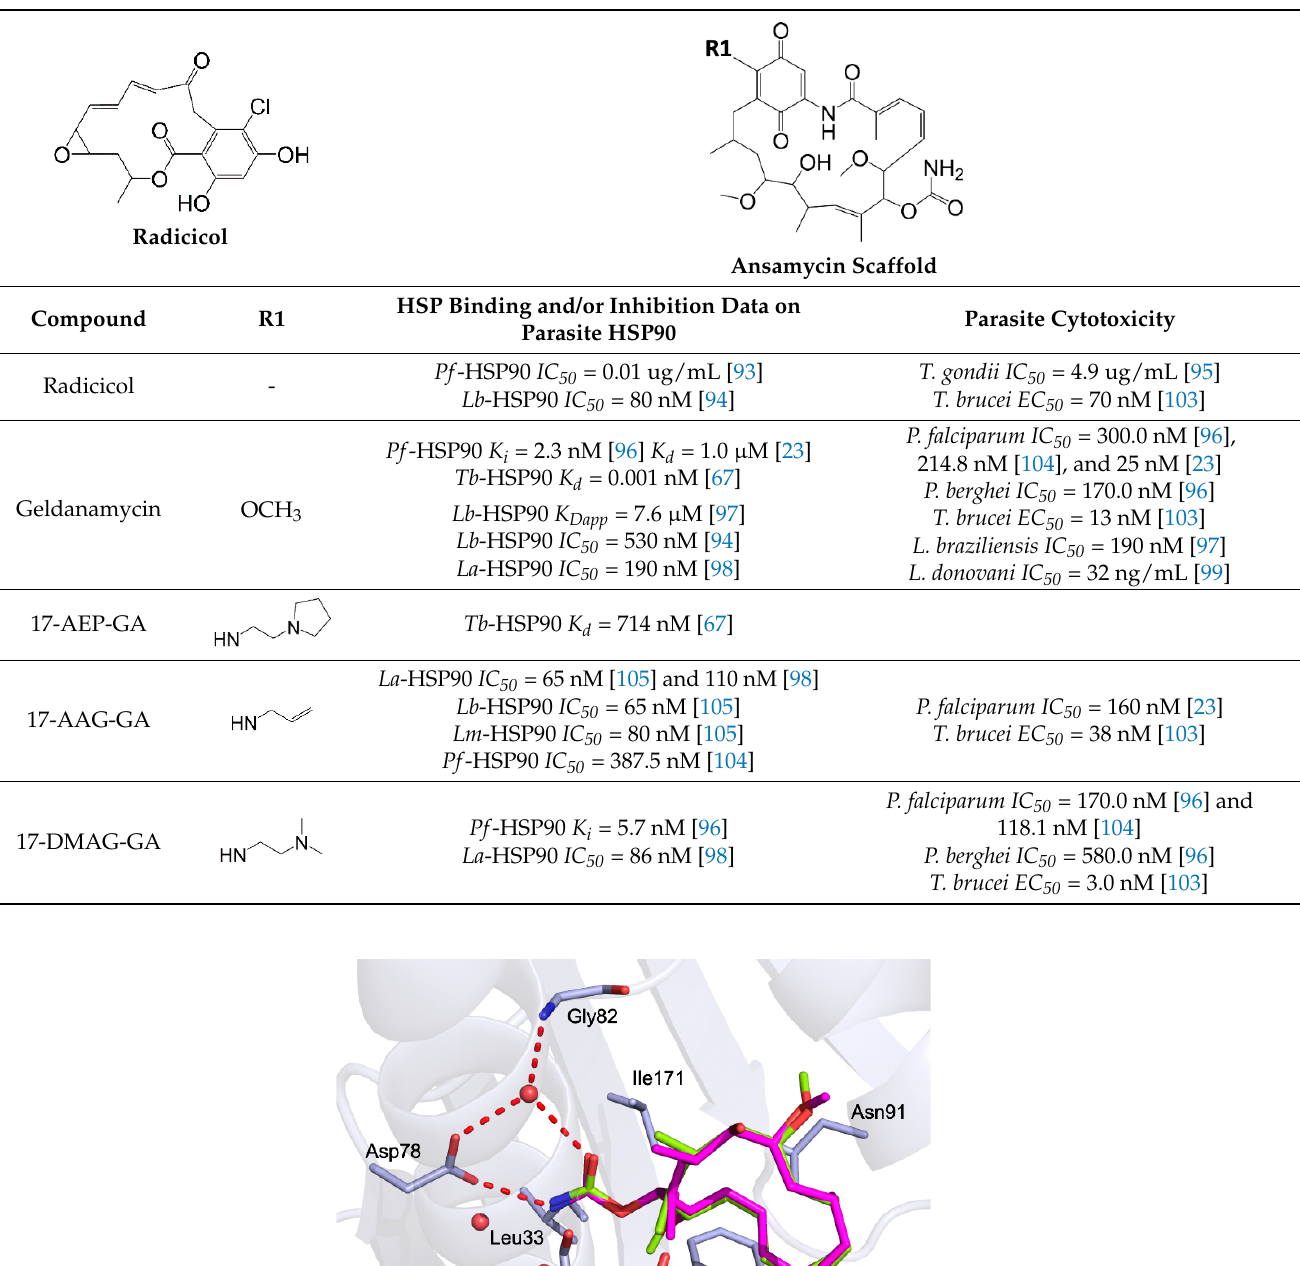
Table 1. HSP90 binding and/or inhibition data, and parasite cytotoxicity by natural macrocyclic compounds and their derivatives.